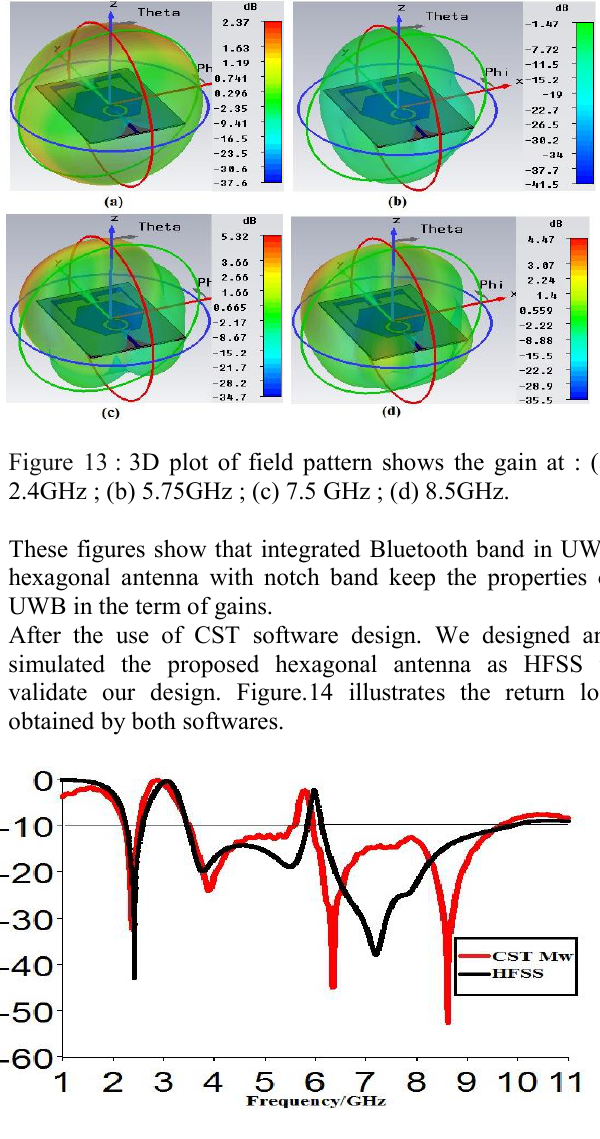
Figure 14: Comparison between the return loss.